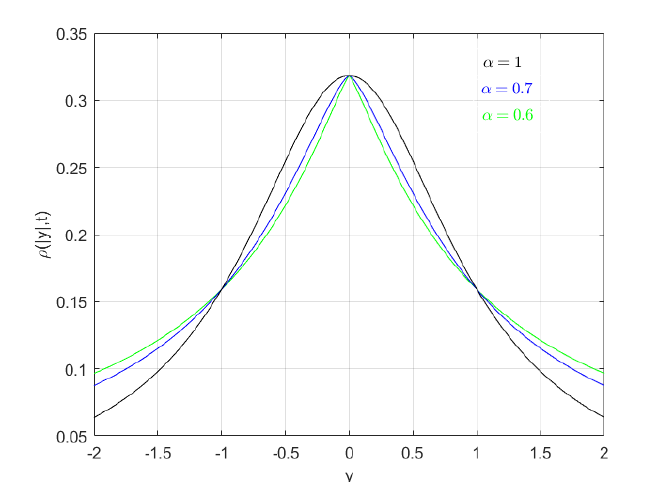
Figure 4. Graph of ρ ( | y | , t ) versus α